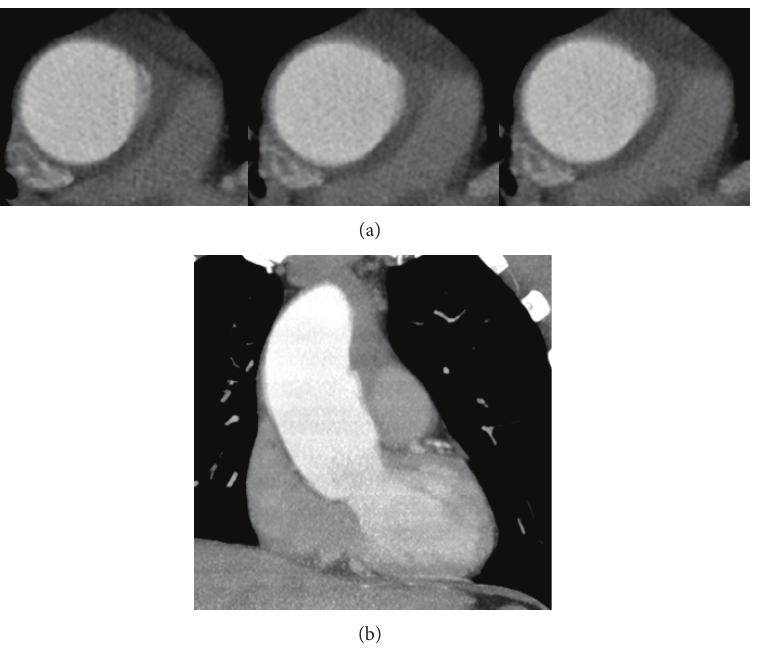
Figure 1: Double-oblique (a) and axial (b)reconstructions (spatial resolution 3 × 0.5 × 0.25 mm) of theinitial inadequate ECG-gated contrast- enhanced CT resulting from repeated premature ventricular contractions at the time of image acquisition. Consider the small contrast signal in the left anterior quadrant of the ascending aorta, misdiagnosed as a pseudointimal flap/motion